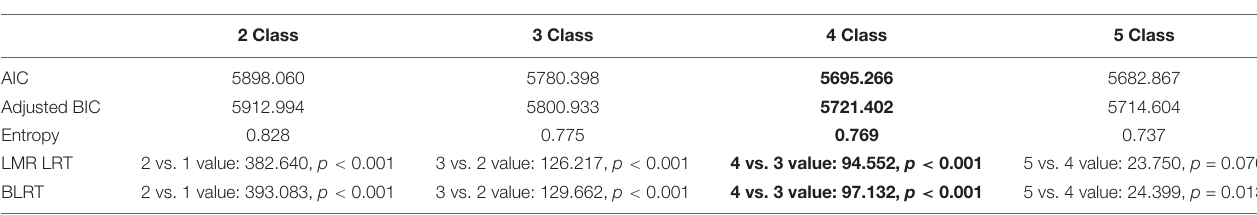
TABLE 2 | Fit indices for latent profile